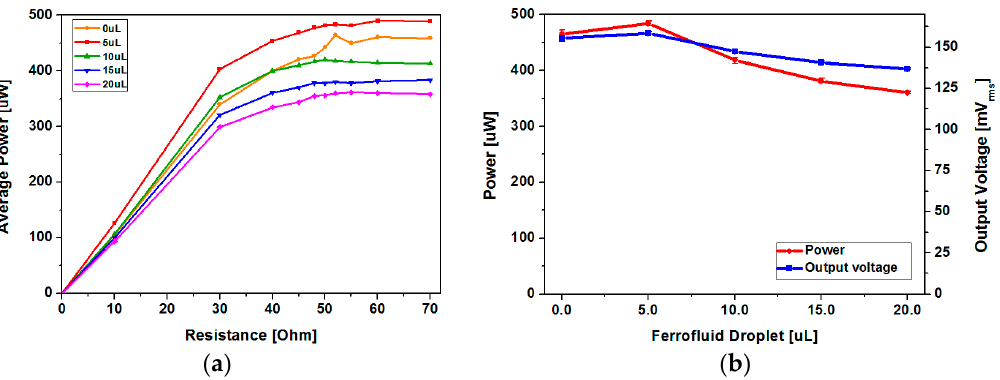
Figure 14. Comparison of the effect of ferrofluid droplet size (3 g acceleration at 13 Hz applied): ( a ) average power at various load resistances; ( b ) power and output RMS voltage at 60 Ω load resistance.